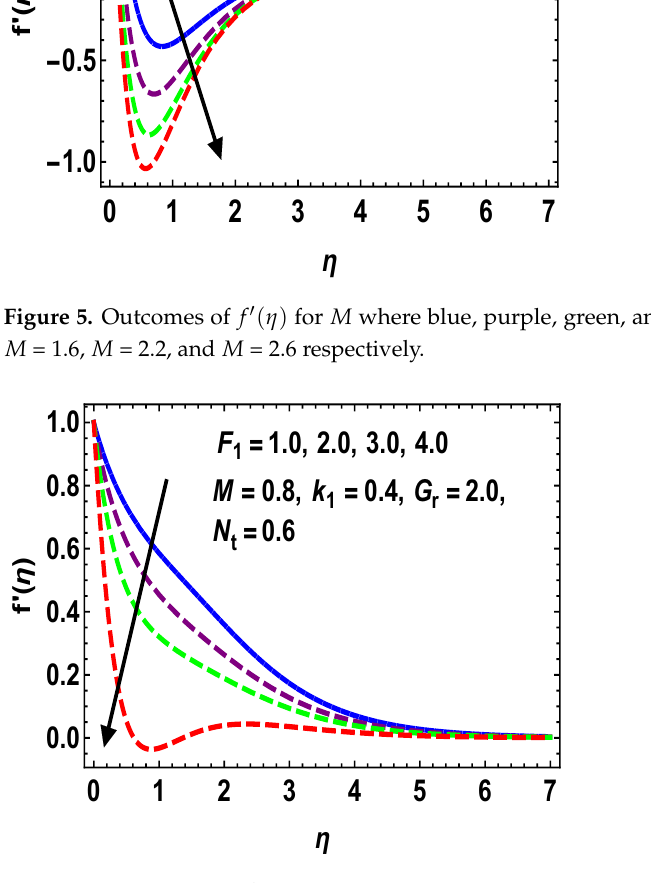
Figure 6. Outcomes of f (cid:48) ( η ) for F 1 where blue, purple, green, and red lines represent for F 1 = 1.0, F 1 = 2.0, F 1 = 3.0, and F 1 = 4.0